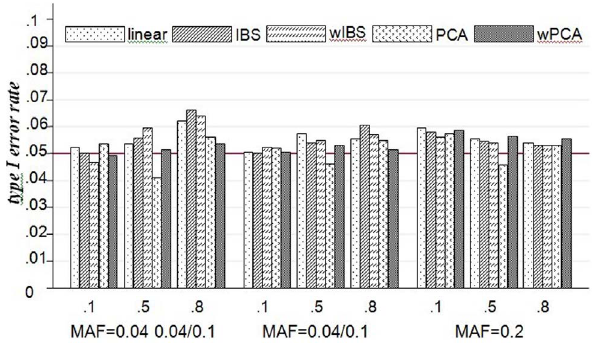
Figure 1. Empirical type I error rates for LKM, PCA and wPCA in scenarios A1–A3. The plot shows the empirical type I error rates (y- axis) based on virtual datasets of each method over the different LD and MAF structures (x-axis) with 20 SNPs. The first line of x-axis represents LD, and the bottom line is MAF.